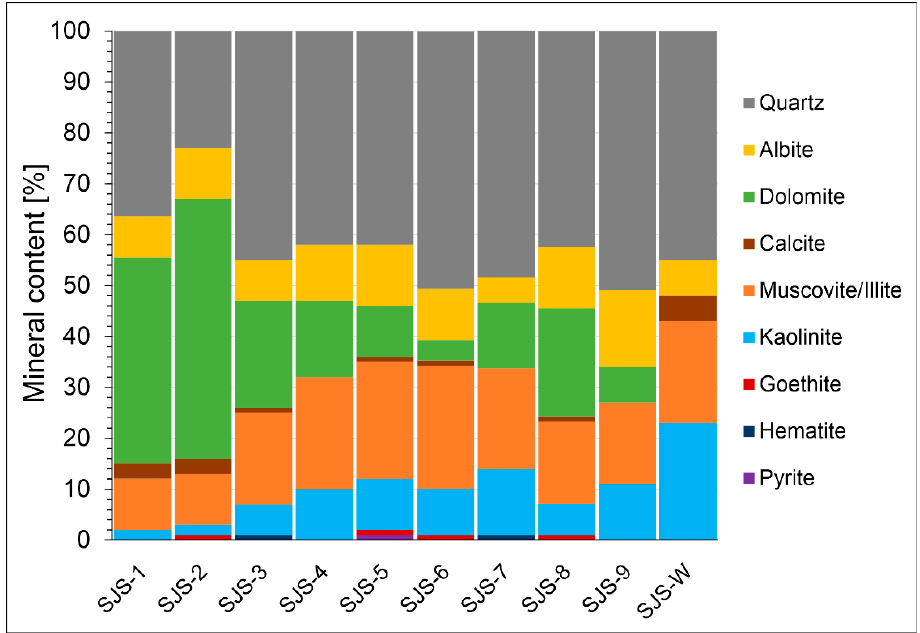
Figure 2. Semi-quantitative distribution of main minerals in stream sediments determined by XRD analysis and expressed in %. Mineral distribution in mine waste (SJS-W) is shown for comparison.